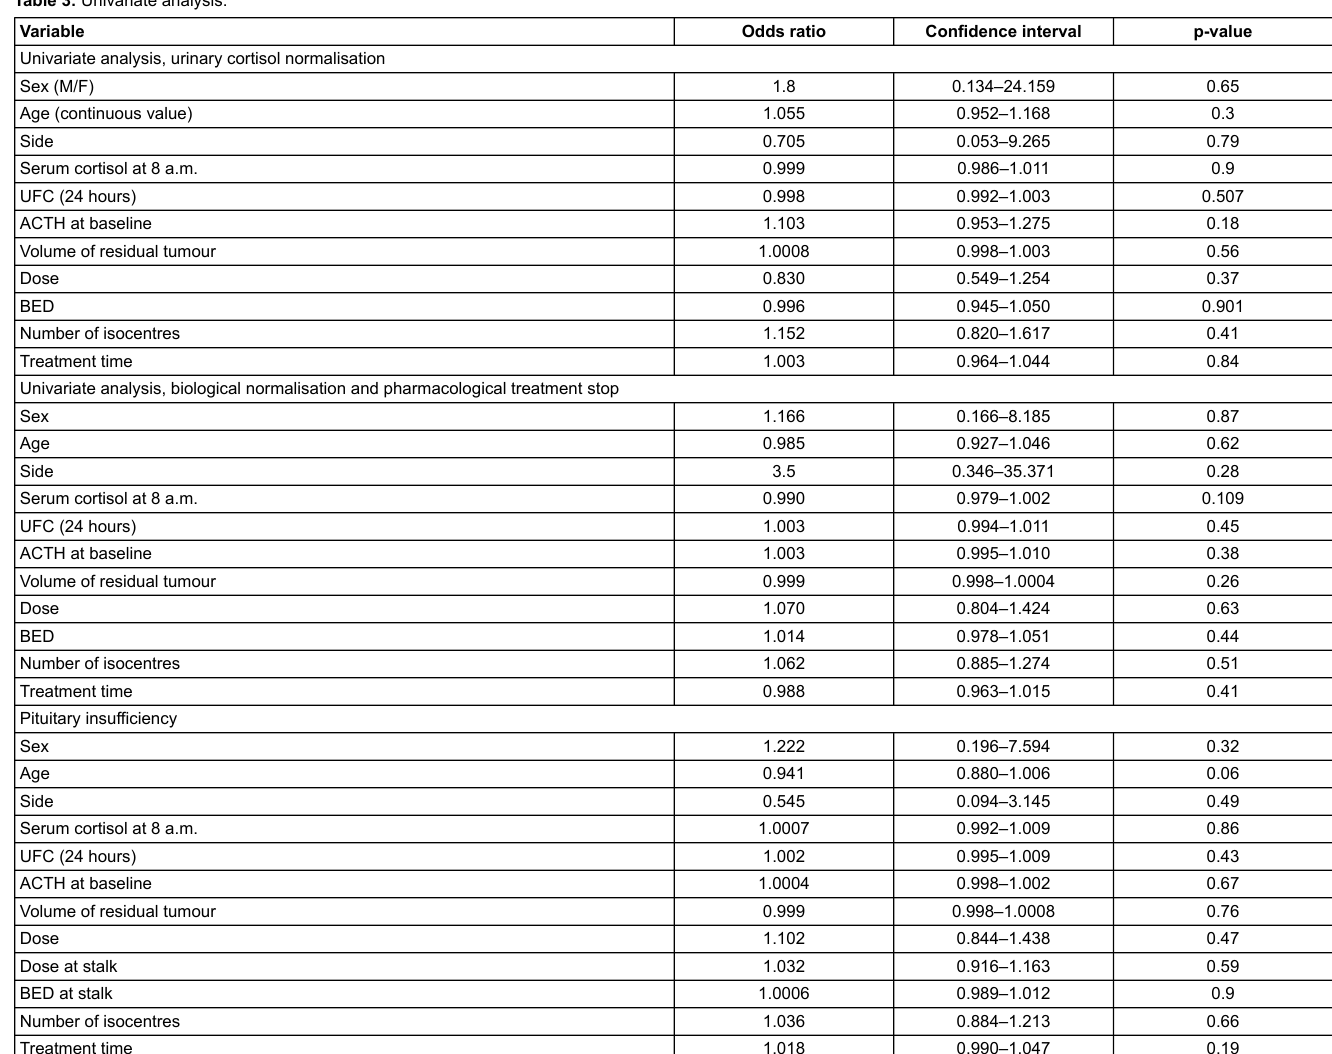
Figure 2: Urinary free cortisol levels before Gamma Knife radio- surgery (GKR) and at last follow-up after GKR.